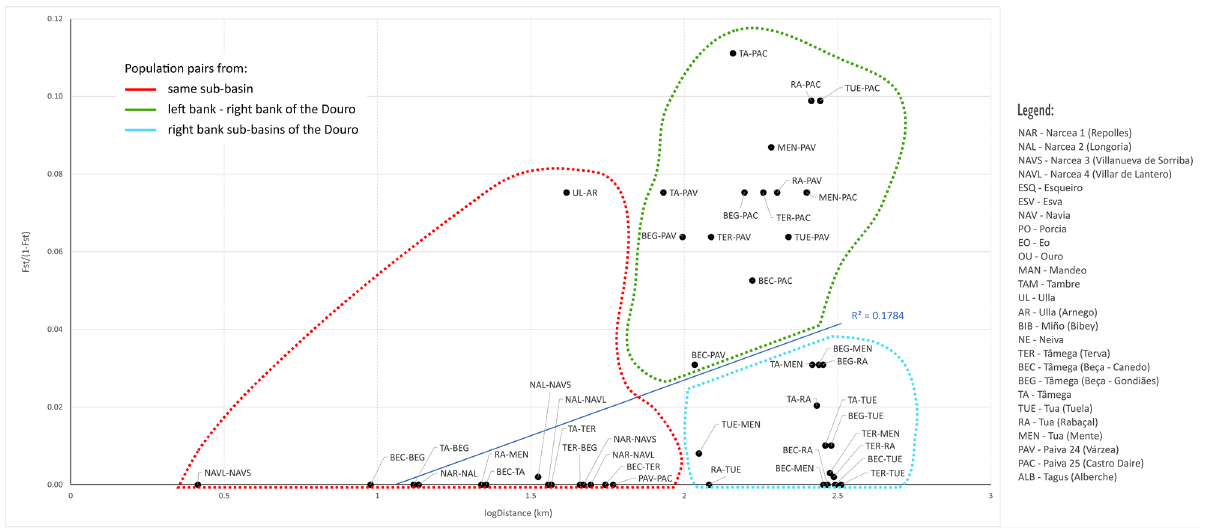
Figure 4. Relation between F ST values (Weir and Cockerham’s estimator) and linear geographic distance between pairs of locations within the same basin (Douro, Ulla and